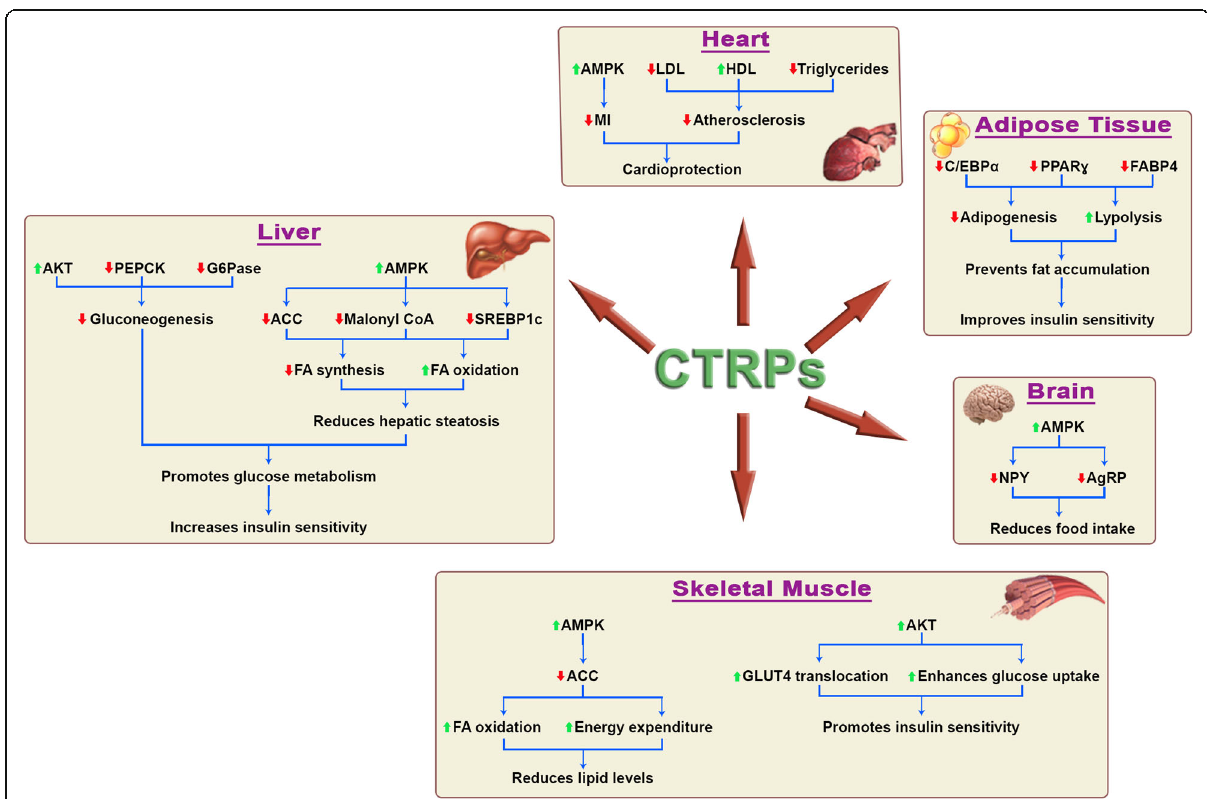
Fig. 3 Illustration of possible signalling pathways and the physiological role of major CTRP family members in metabolic